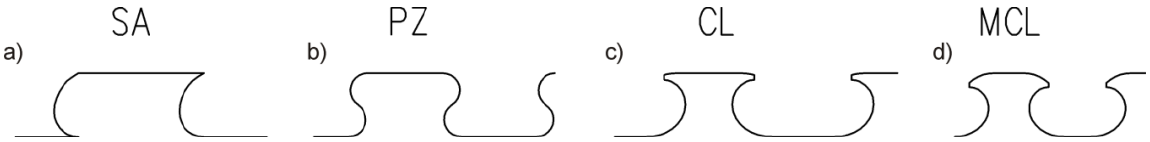
Figure 4: Shapes of composite dowels a) fin SA, b) puzzle PZ, c) clothoidal CL, and d) modified clothoidal